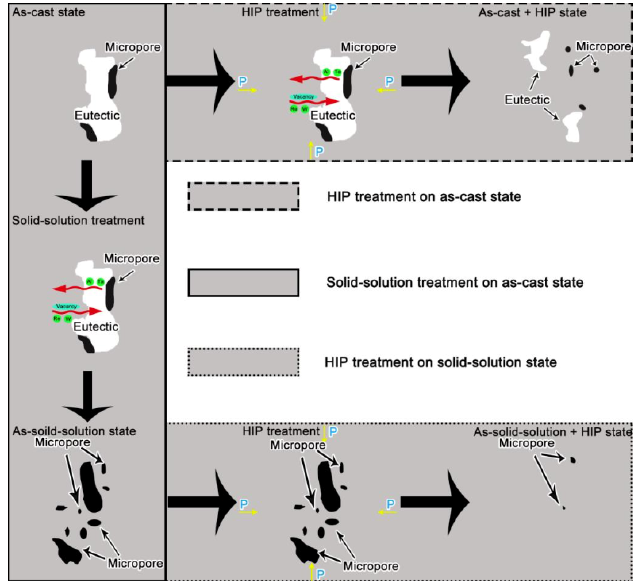
Figure 18. The changes of in terdendritic eutectic and micropores of used nickel-based SX superalloy under different states during HIP treatment [23] .